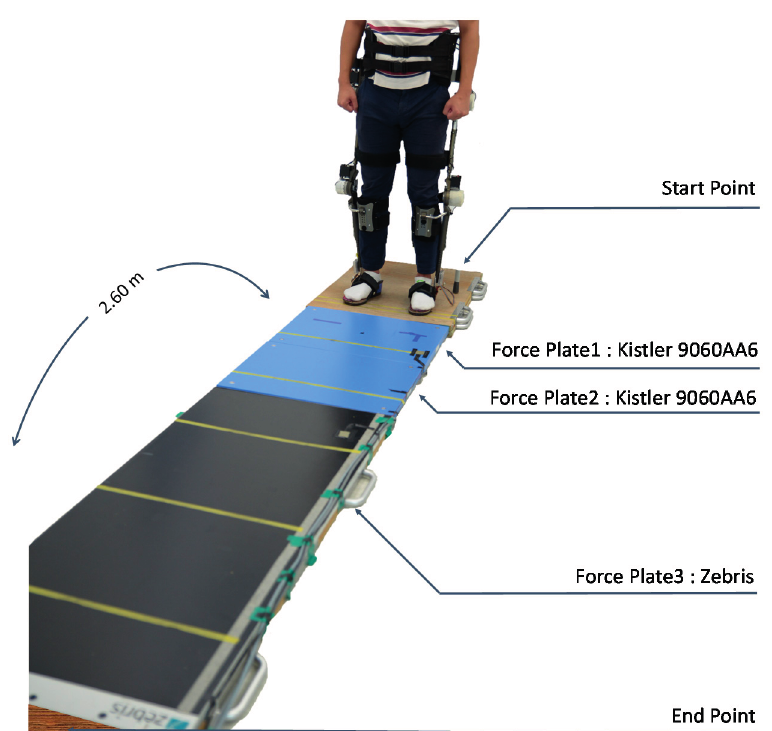
Figure 2. Configuration of the environment for the walking experiments. Total walking length from start point to end point was 2.60 m. Three force plates were used to acquire ground reaction forces while walking. The subjects start walking at the start point and end walking at the end point while maintaining a standing